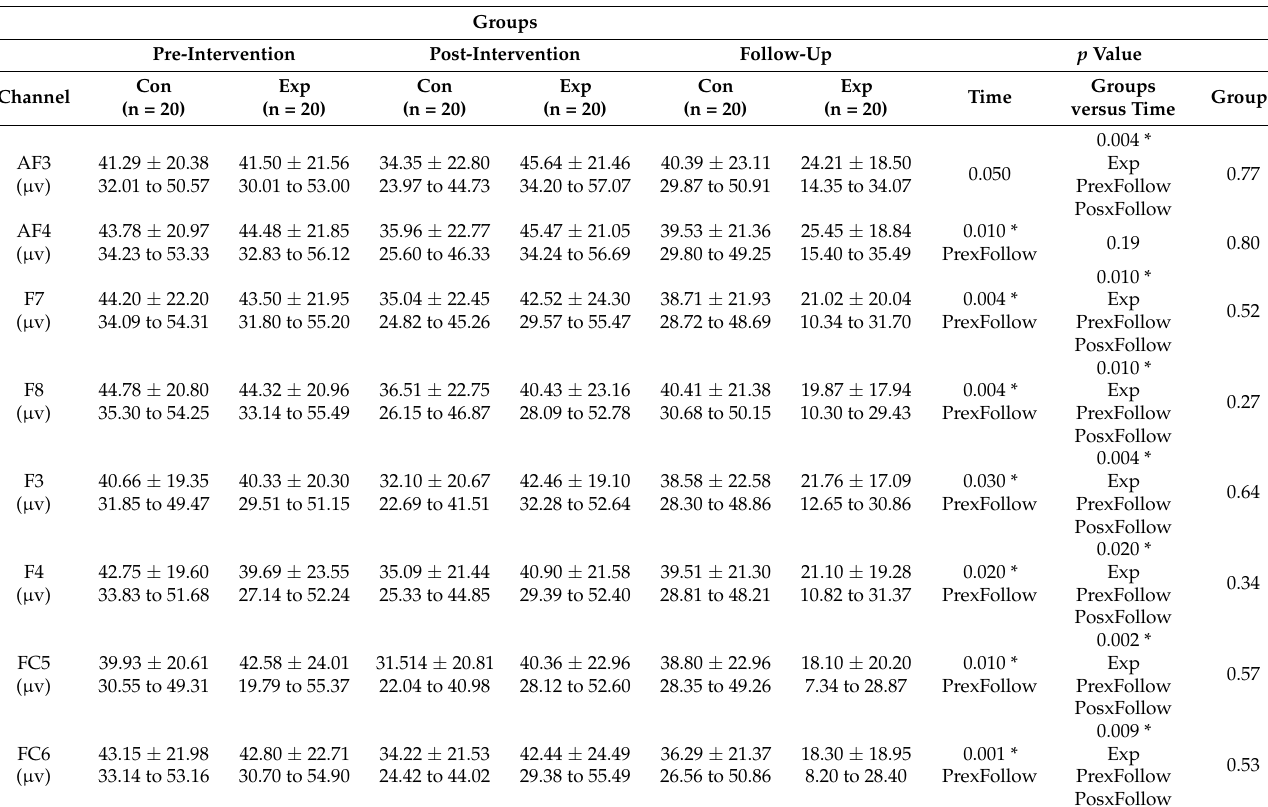
Table 3. Mean, SD, and CI (95%) of groups, difference within groups, difference between groups of the variable EEG with eyes